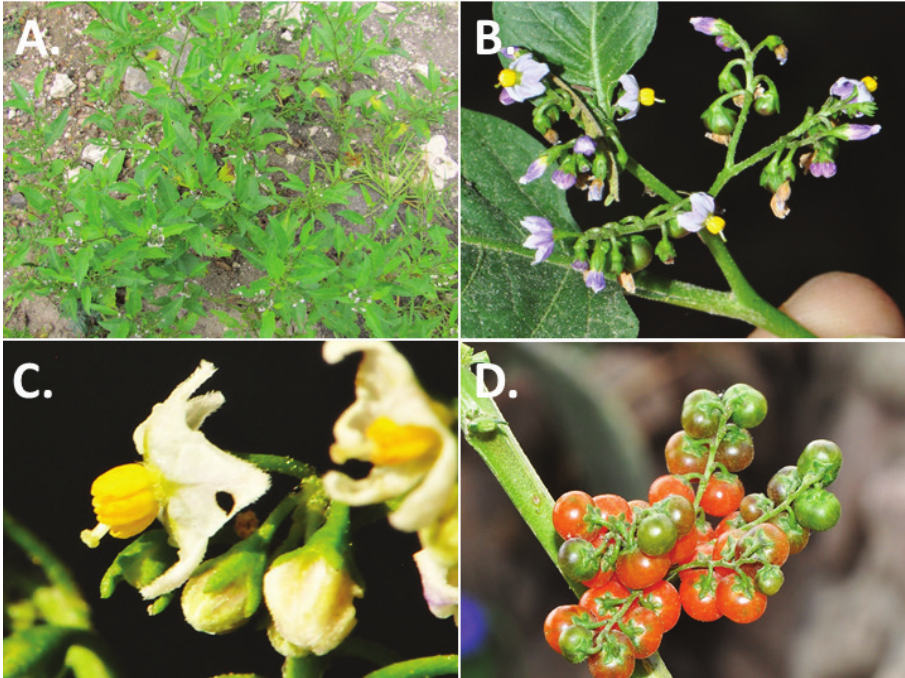
Figure 10. Solanum corymbosum Jacq. A Habit B inflorescence C flowers at full anthesis and buds D fully mature red-orange fruits with appressed calyx lobes ( A Särkinen et al. 4604B B, D Särkinen et al. 4078 ; D Särkinen et al. 4509 ). Photos by T.